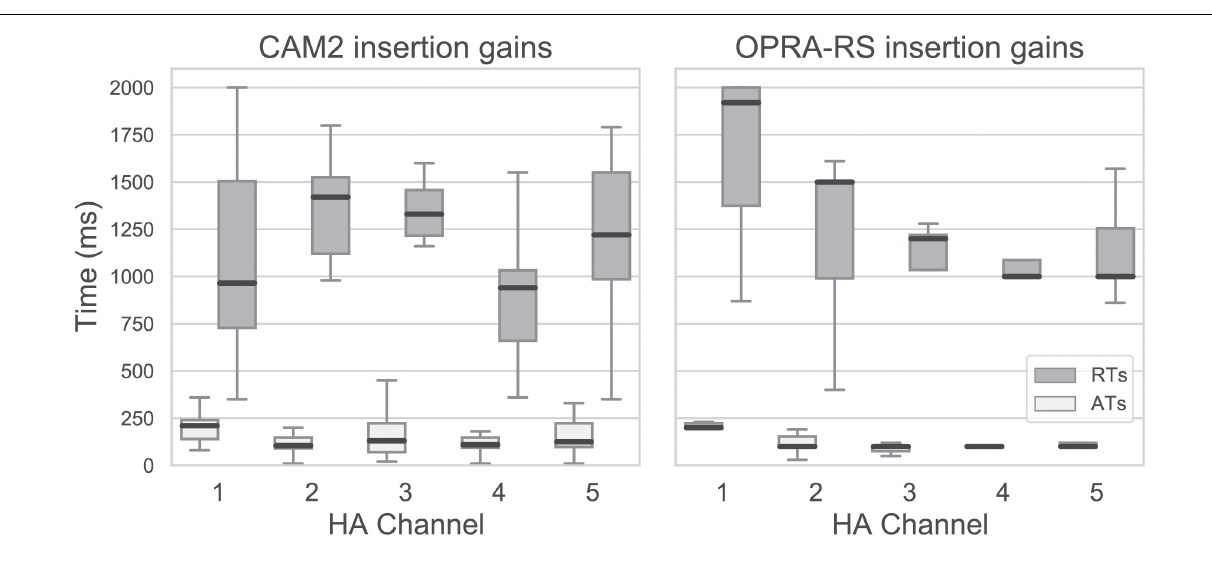
FIGURE 4 | Distribution of the attack times (ATs) and release times (RTs) yielding the highest ASR performances when using the insertion gains recommended by CAM2 (left panel) or OPRA-RS (right panel) for the 12 audiograms. Otherwise as Figure 3